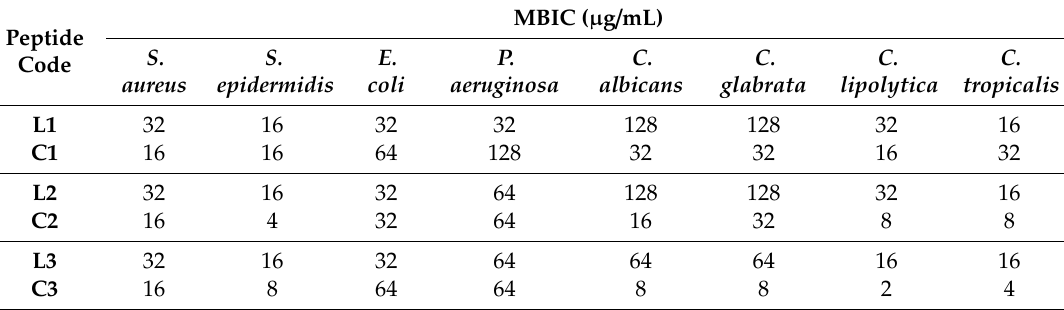
Table 4. Biofilm inhibitory activity of